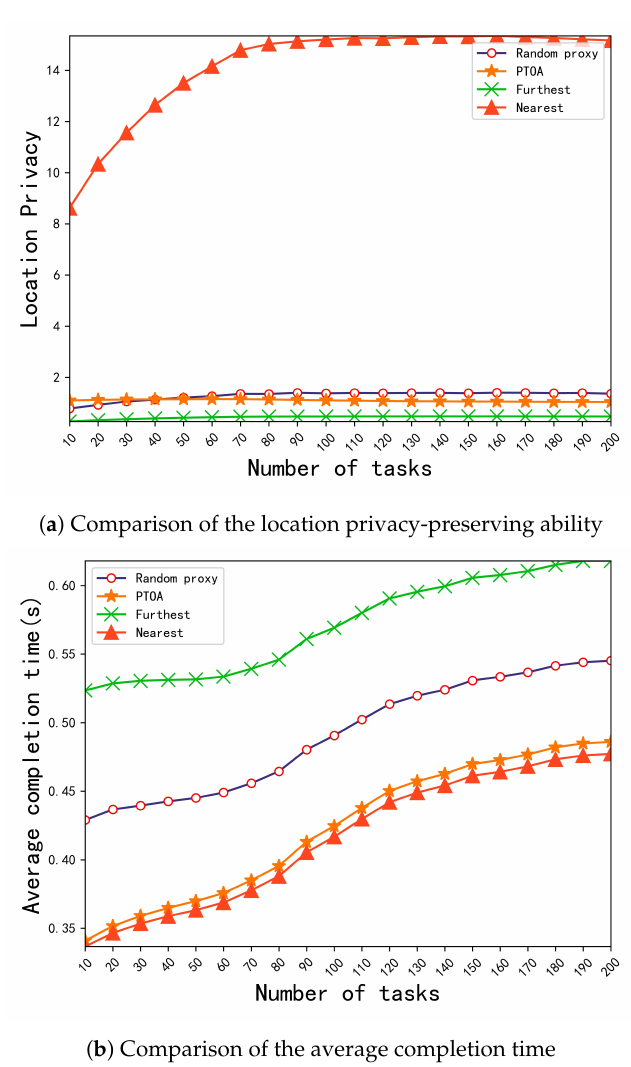
Figure 4. Comparison of the location privacy-preserving ability and average completion time for four different proxy server selection strategies Random proxy, PTOA, Furthest, and Nearest with different numbers of tasks.